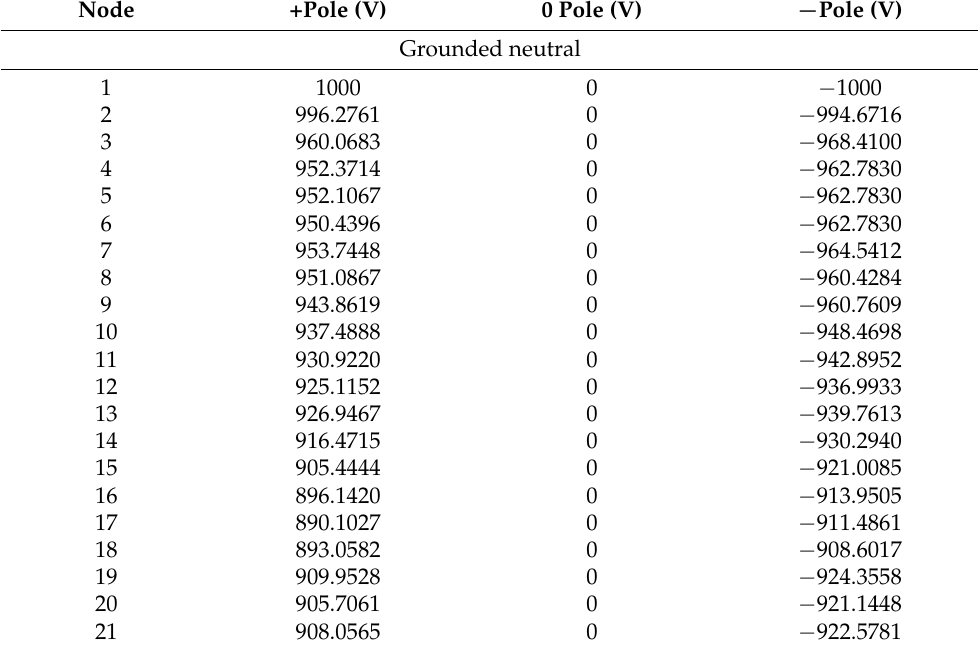
Table 3. Voltage for both simulation cases in the 21-bus